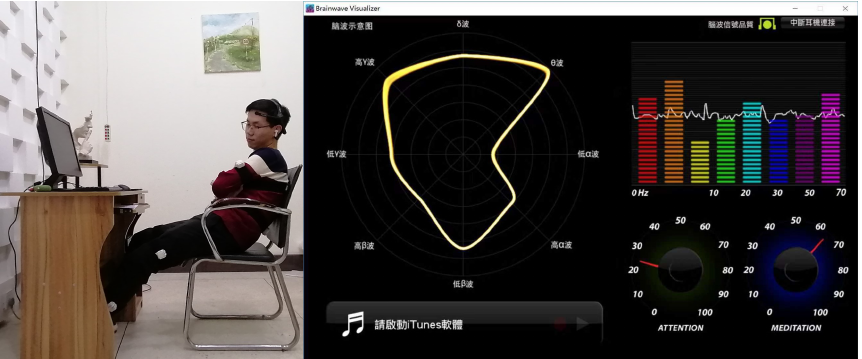
Figure 18. Brainwave Visualizer. The EEG signals, “Attention”, and “Meditation” of listening to music at 3000 k–300